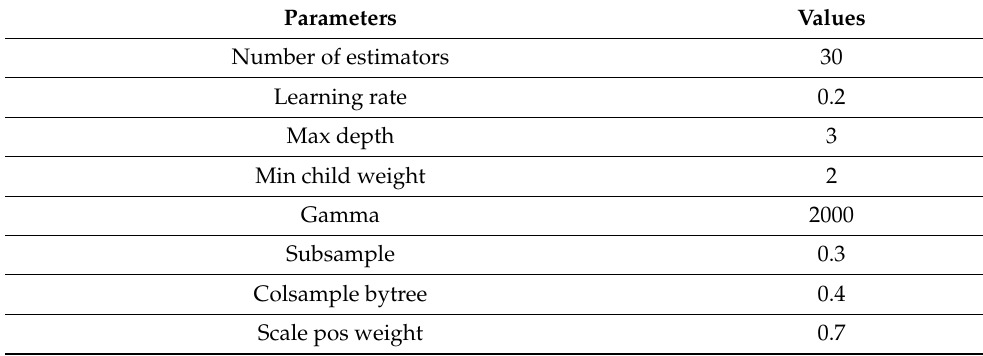
Figure 6. Goodness of fit with different numbers of hidden layers and neurons. Table 1. Parameters of